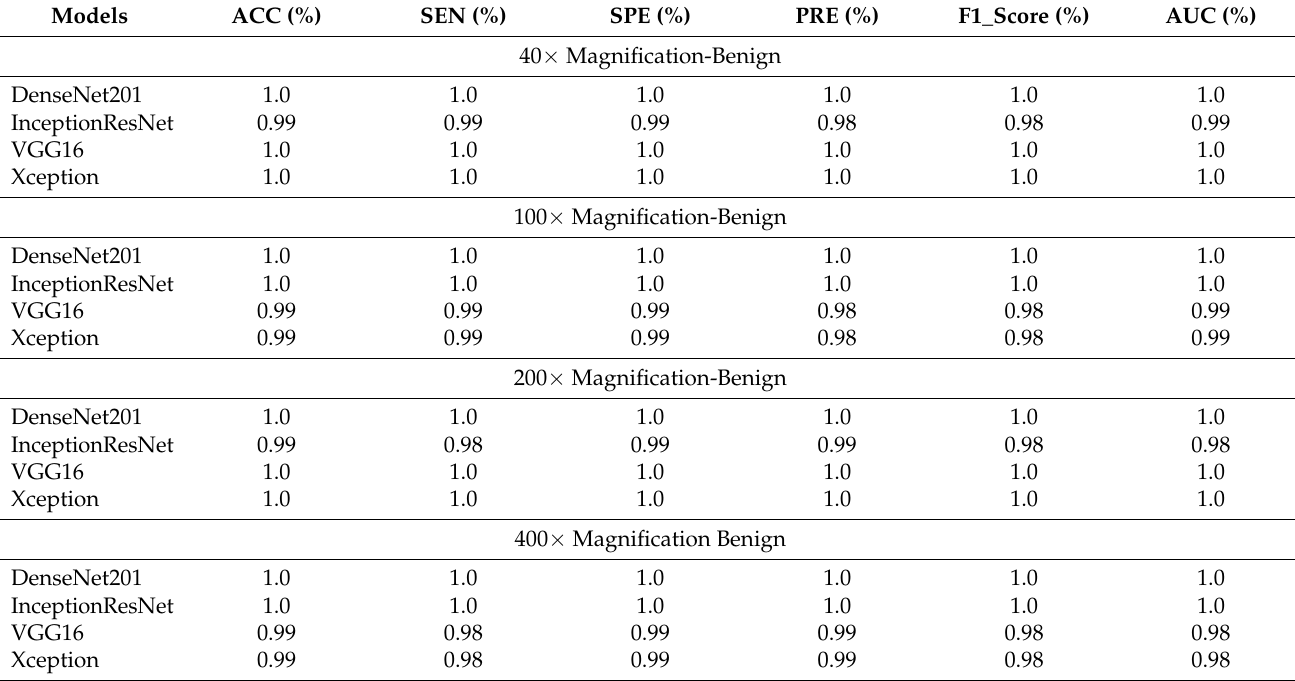
Table 7. Transfer learning classification result. The experiment was performed specifically for the selection of the proposed model